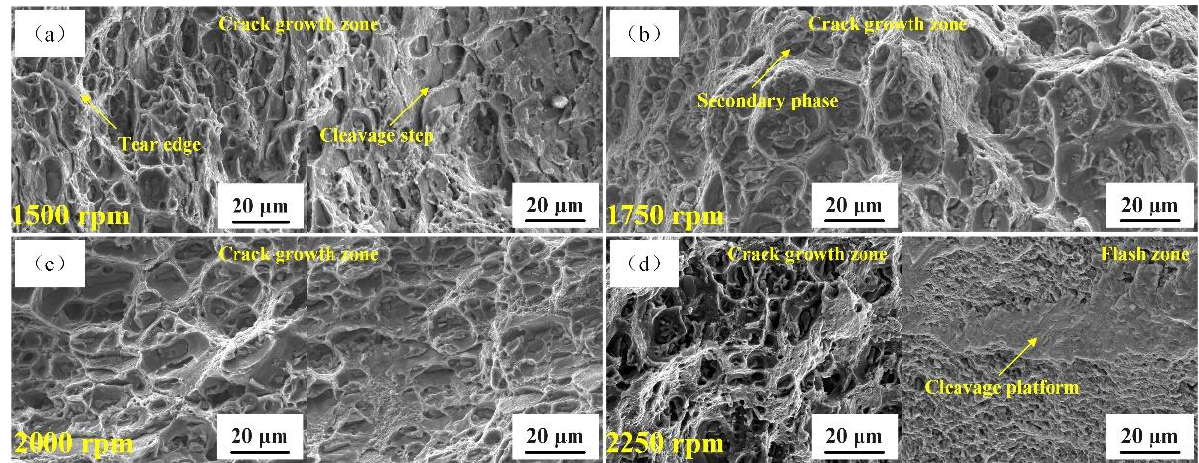
Figure 14. Fracture morphologies of the T-joint’s base plate at different rotation speeds of the stirring pin: ( a ) 1500 rpm; ( b ) 1750 rpm; ( c ) 2000 rpm; ( d ) 2250 rpm.